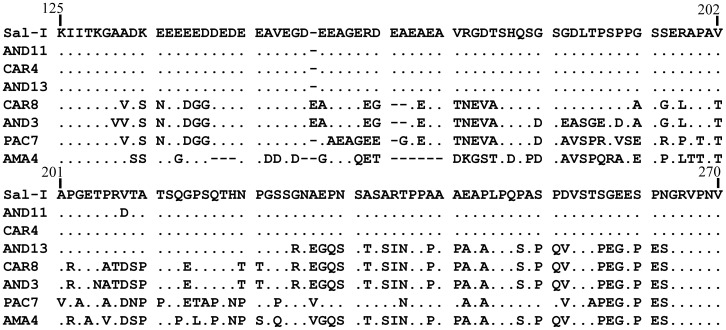
Alignment of deduced PvMSP-7I amino acid sequences, including the Sal-I sequence in which the protein sequences differentiating major allele types can be observed.Dots indicate conserved residues and dashes represent gaps introduced for alignment.